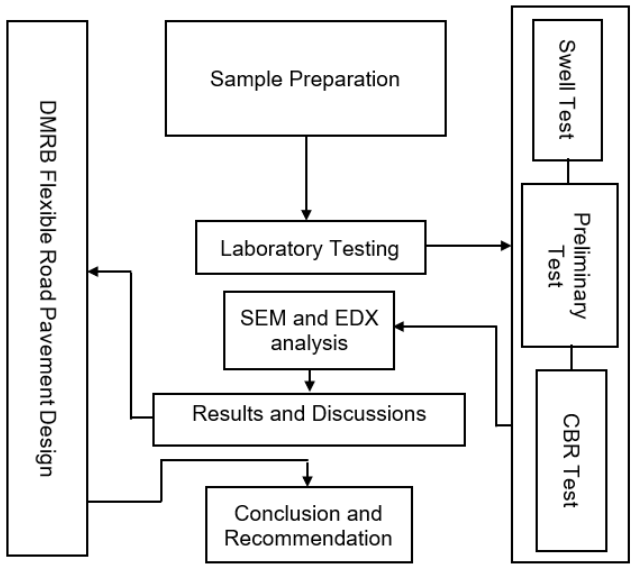
Figure 3. The methodological process used in this